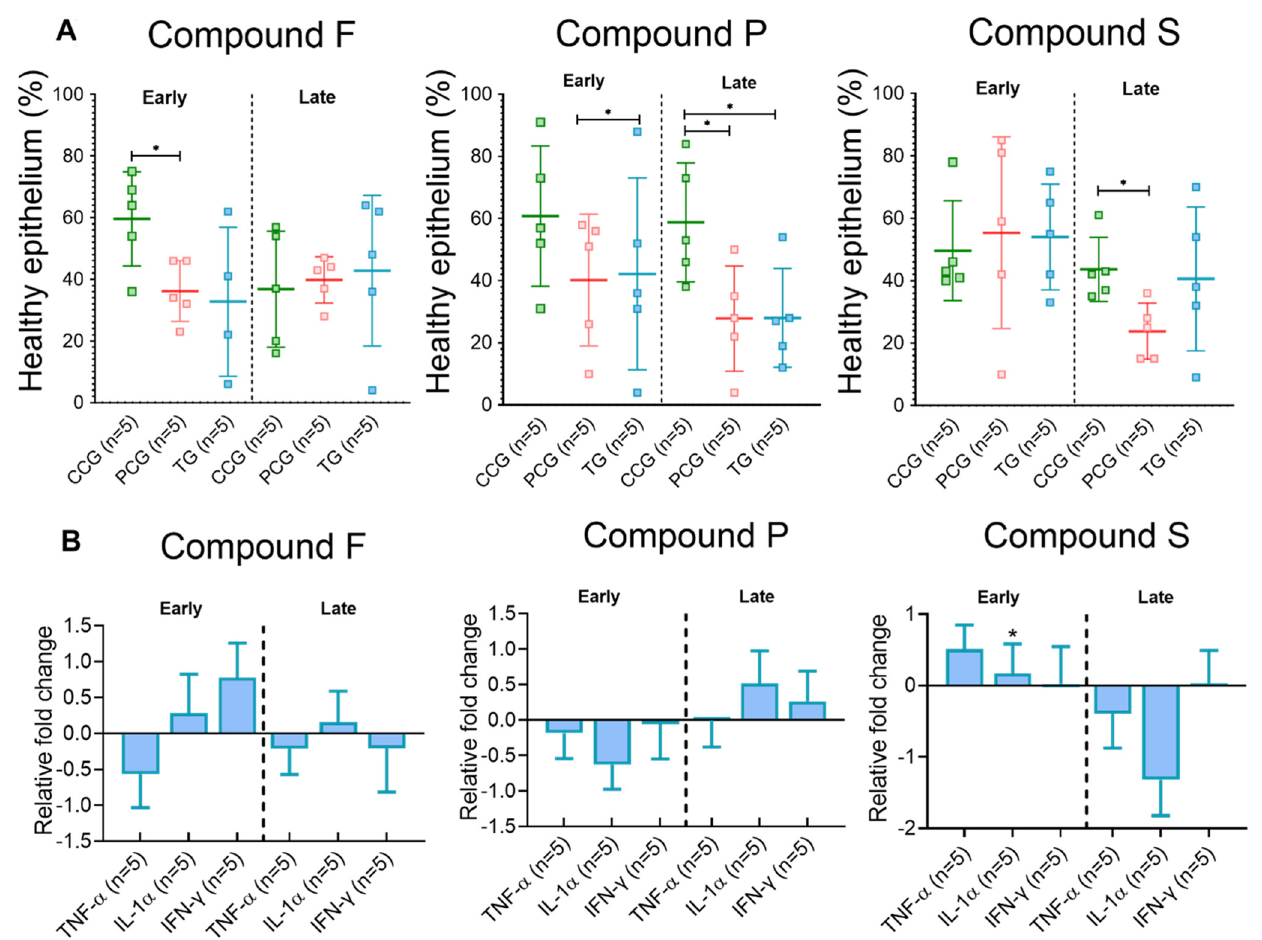
Figure 3. Microscopical changes and gene expression data from explants challenged with S. Typhimurium. ( A ) Histopathology assessment. Horizontal lines represent group mean, and whiskers depict standard deviation from the mean. ( B ) Gene expression data is reported as fold change from TG samples using the PCG as reference. Compound control group (CCG), pathogen control group (PCG), treatment group (TG). Bars represent mean mRNA levels; whiskers depict standard deviation from the mean. Star denotes significant difference ( p ≤ 0.05).